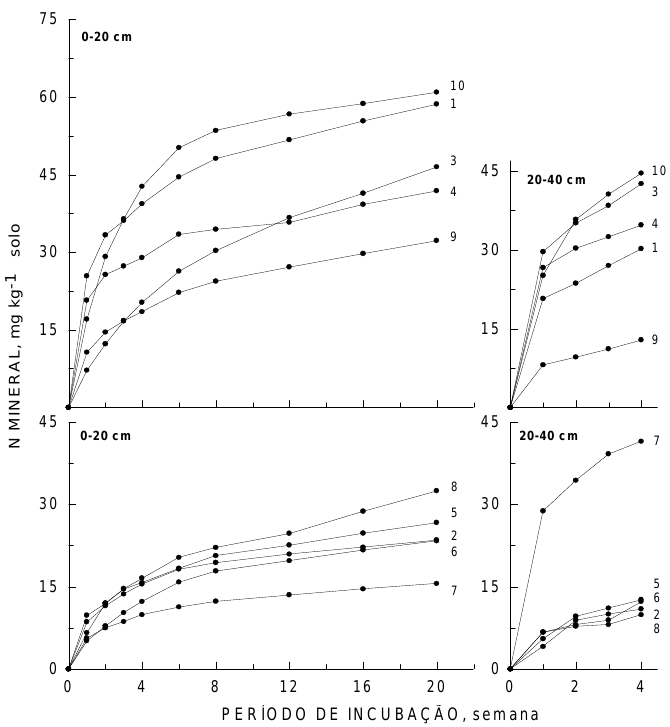
Figura 1. Mineralização acumulada de nitrogênio (NH 4+ + NO 3- ) em amostras das camadas de 0-20 e